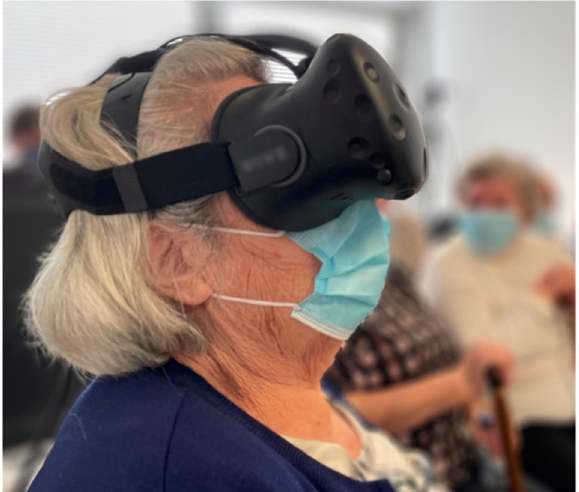
Figure 2. Participant testing the HMD in the first phase of the